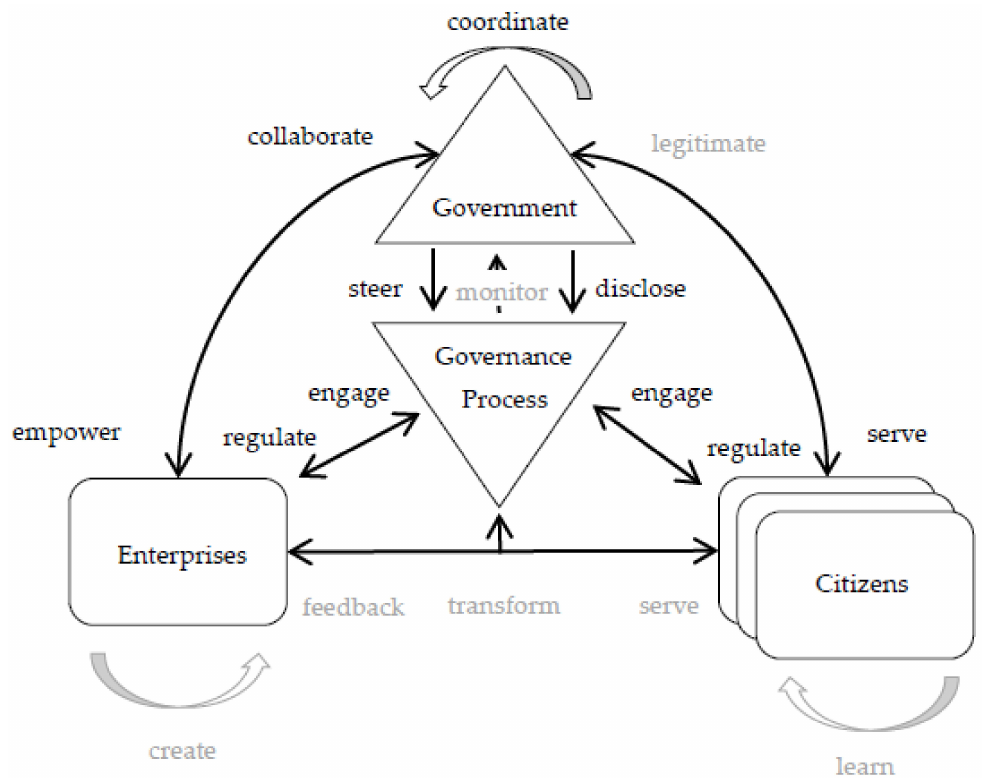
Figure 4. Framework instantiation, Zhejiang Internet plus government service project